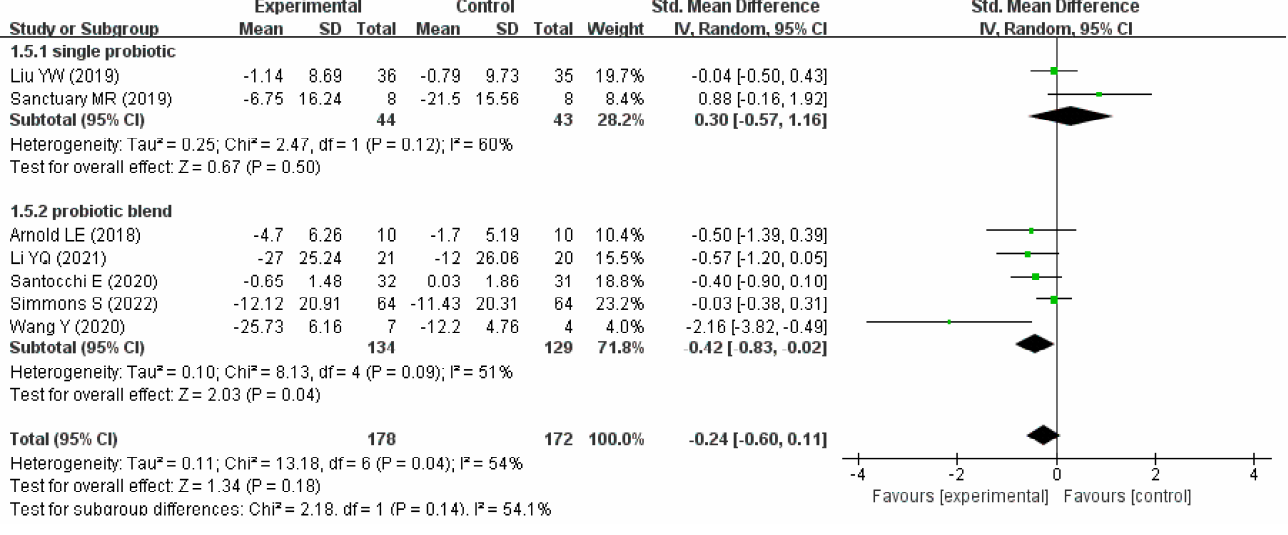
Figure 5. Forest plot for the subgroup analysis stratified by intervention measures [23,25,27–30,32].